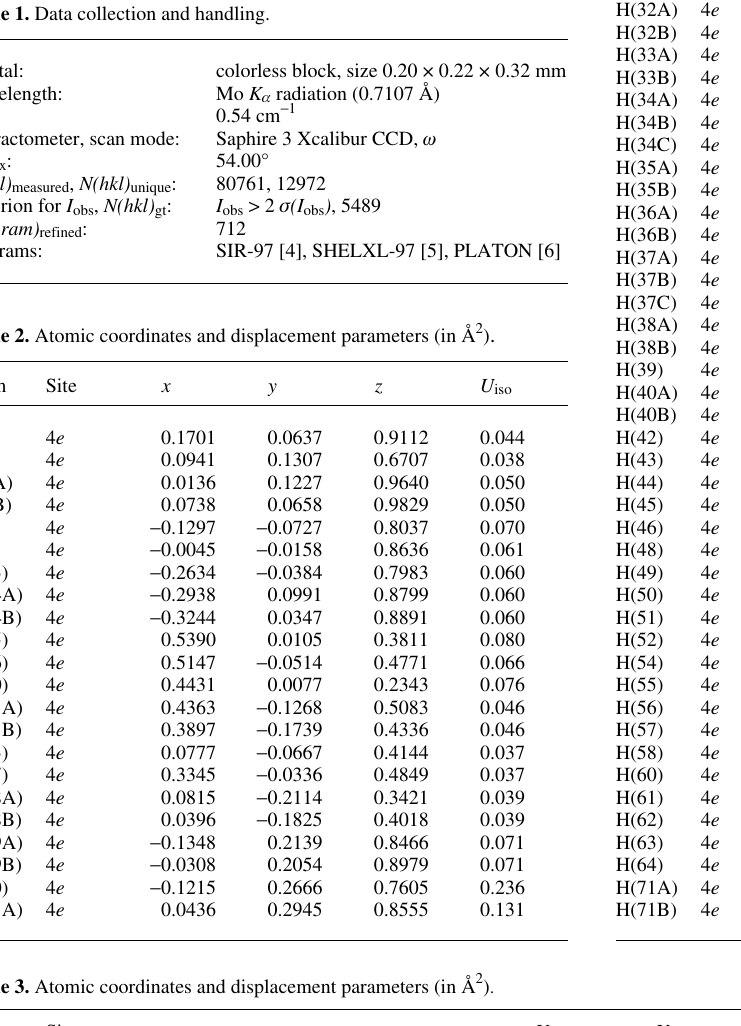
Table 1. Data collection and